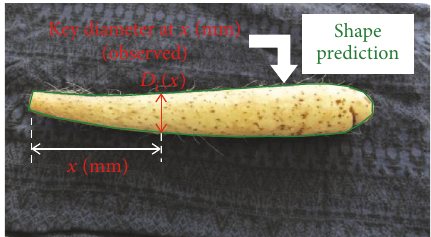
Figure 3: Step 0 . All yams are arranged into [0,1] interval.